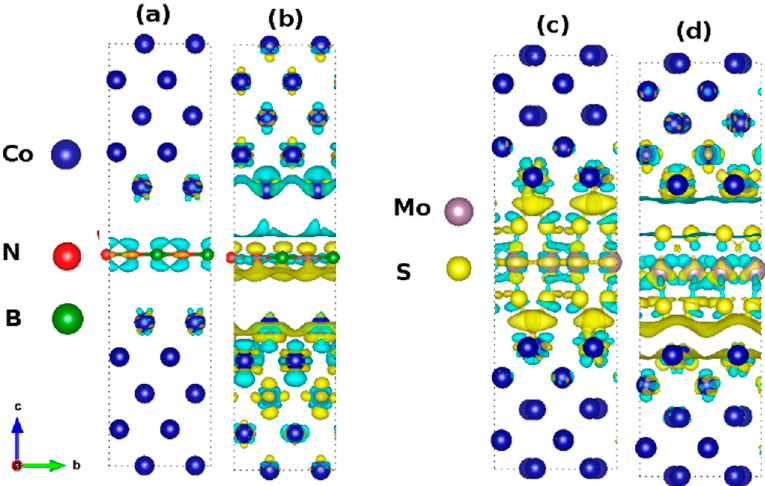
Figure 6. Difference charge density for a stack containing monolayer hBN (left panel) and MoS 2 (right panel) tunnel barrier at applied electric field of amplitude 0.0 [( a , c )] and 0.1 a.u. [( b , d )]. Yellow and cyan denote electron accumulation and depletion regions, respectively.